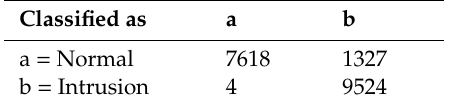
Table 10. Confusion matrix of using One-Class Support Vector Machine.